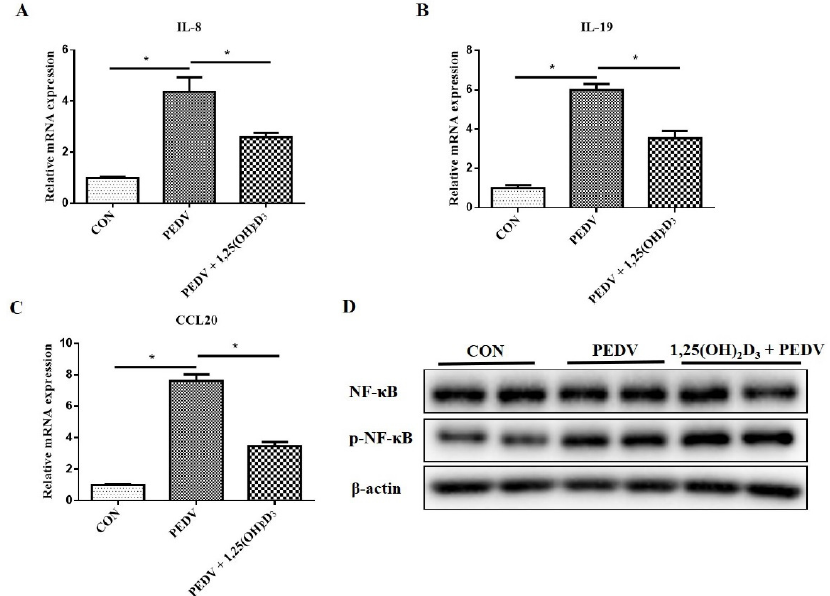
Figure 2. Effects of 1,25(OH) 2 D 3 on the inflammatory cytokine expression in PEDV-infected IPEC-J2 cells at 1 h post-infection. The sub-confluent cells were incubated with 1,25(OH) 2 D 3 (20 nM) for 24 h, after which the cells were infected with PEDV (1 MOI). After 1 h of absorption, the cells were washed with PBS and then cultured with 1,25(OH) 2 D 3 (20 nM) for 1 h. Then, the cells were collected for RT-qPCR ( A – C ) and Western blotting analysis ( D ). * p < 0.05. Nevertheless, pretreatment with 1,25(OH) 2 D 3 significantly suppressed IL-19 and CCL20 mRNA expression and decreased p -NF- κ B protein levels induced by PEDV at 24 h post-infection in IPEC-J2 cells (Figure 3A). Moreover, we also confirmed that 1,25(OH) 2 D 3 could inhibit PEDV-induced proinflammatory cytokine expression and p -NF- κ B protein levels at 24 h post-infection in 3D4/21 cells (Figure 3B). The results indicated that 1,25(OH) 2 D 3 not only inhibited the inflammatory response induced by PEDV infection in intestinal epithelial cells, but also in immune cells.